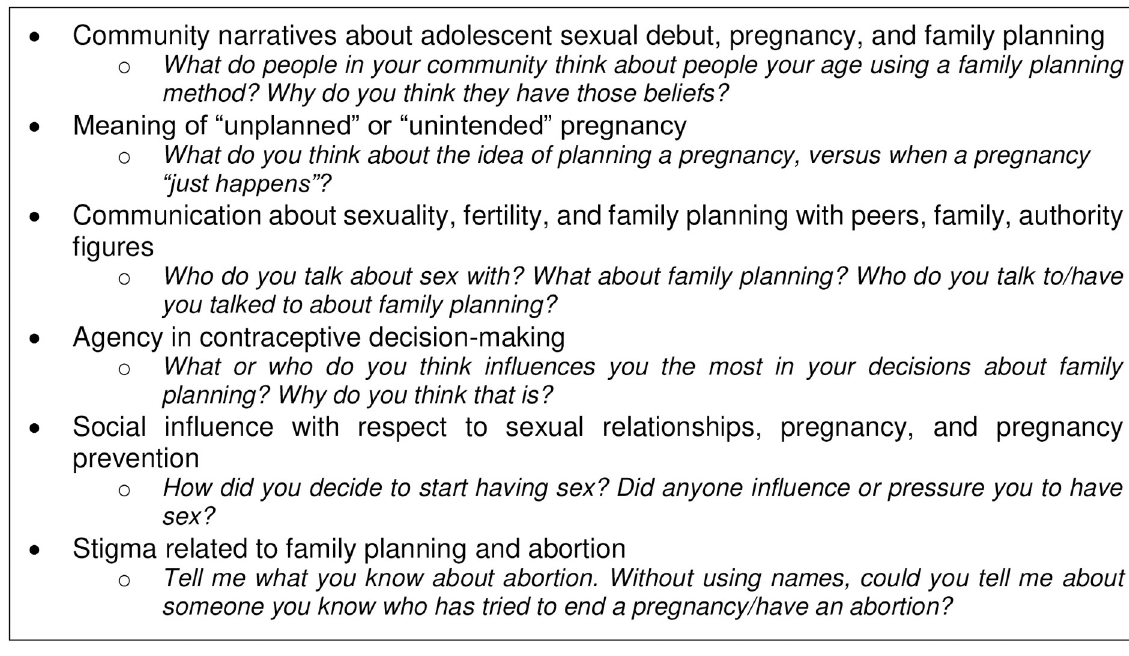
Fig 1. Primary in-depth interview/focus group discussion domains and sample